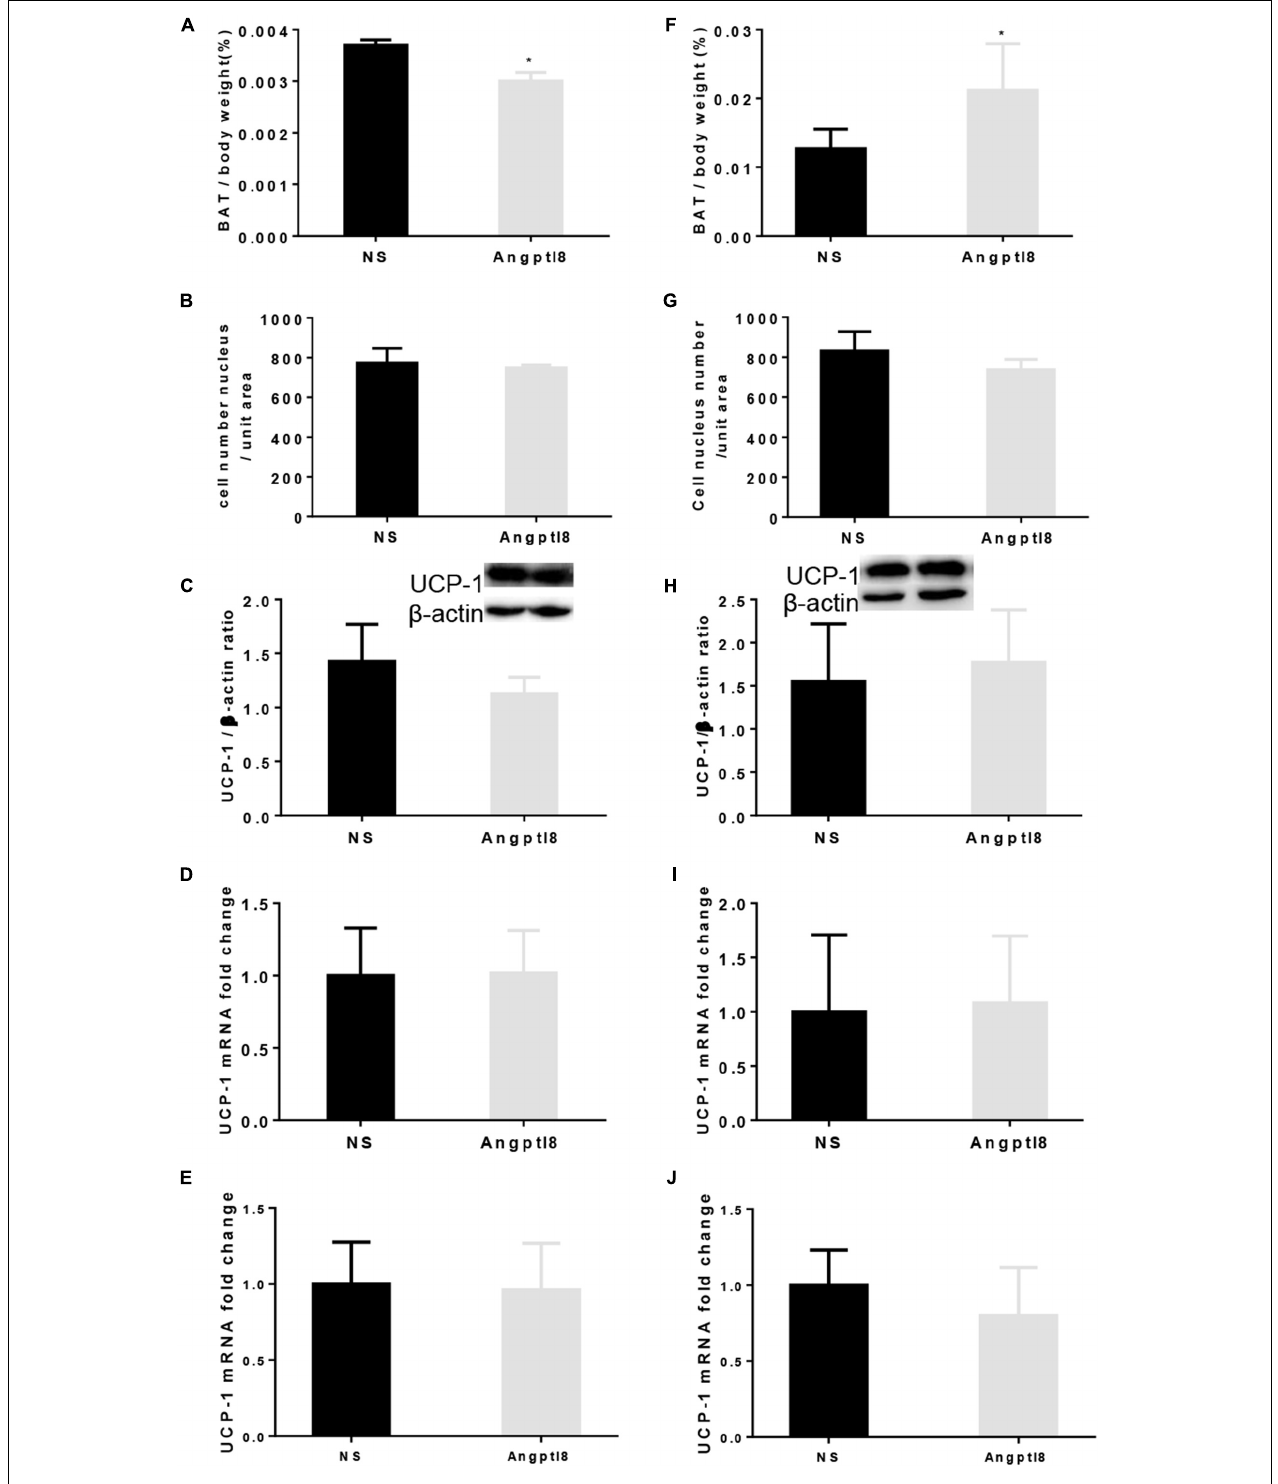
FIGURE 7 | Effect of peripheral and central Angptl8 on BAT mass, BAT morphology, and Ucp-1 expression. Angptl8 (30 µ g/ml) via I.V. injection ( n = 6 and 3 in experimental and control group, respectively) decreased BAT deposit (A) but had no effect on BAT cell density (B) and Ucp-1 expression (C–E) . (D) Use β -actin as the HKG and (E) use GAPDH as the HKG. Angptl8 (0.3 µ g/ µ l) via I.C.V. injection ( n = 7 and 3 in experimental and control group, respectively) increased BAT deposit (F) but had no effect on BAT morphology (G) or Ucp-1 expression (H–J) . (I) Use β -actin as the HKG and (J) use GAPDH as the HKG. Data are means ± SEM. ∗ P < 0.05 relative to the NS control